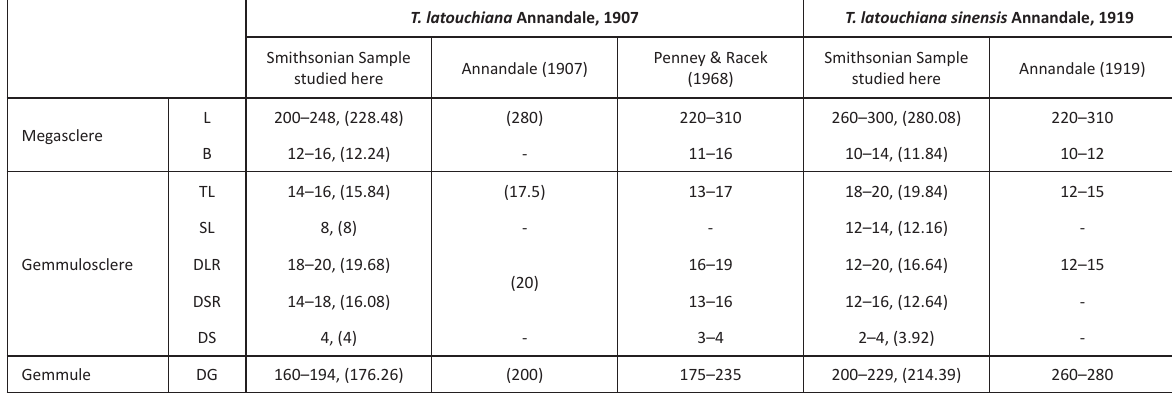
L - length of megasclere; B - breadth of megasclere; TL - total length of gemmulosclere; SL - shaft length of gemmulosclere, between the rotules; DLR - diameter of larger (lower/inner) rotule; DSR - diameter of smaller (upper/outer) rotule; DS - diameter of shaft of gemmulosclere; DG - diameter of